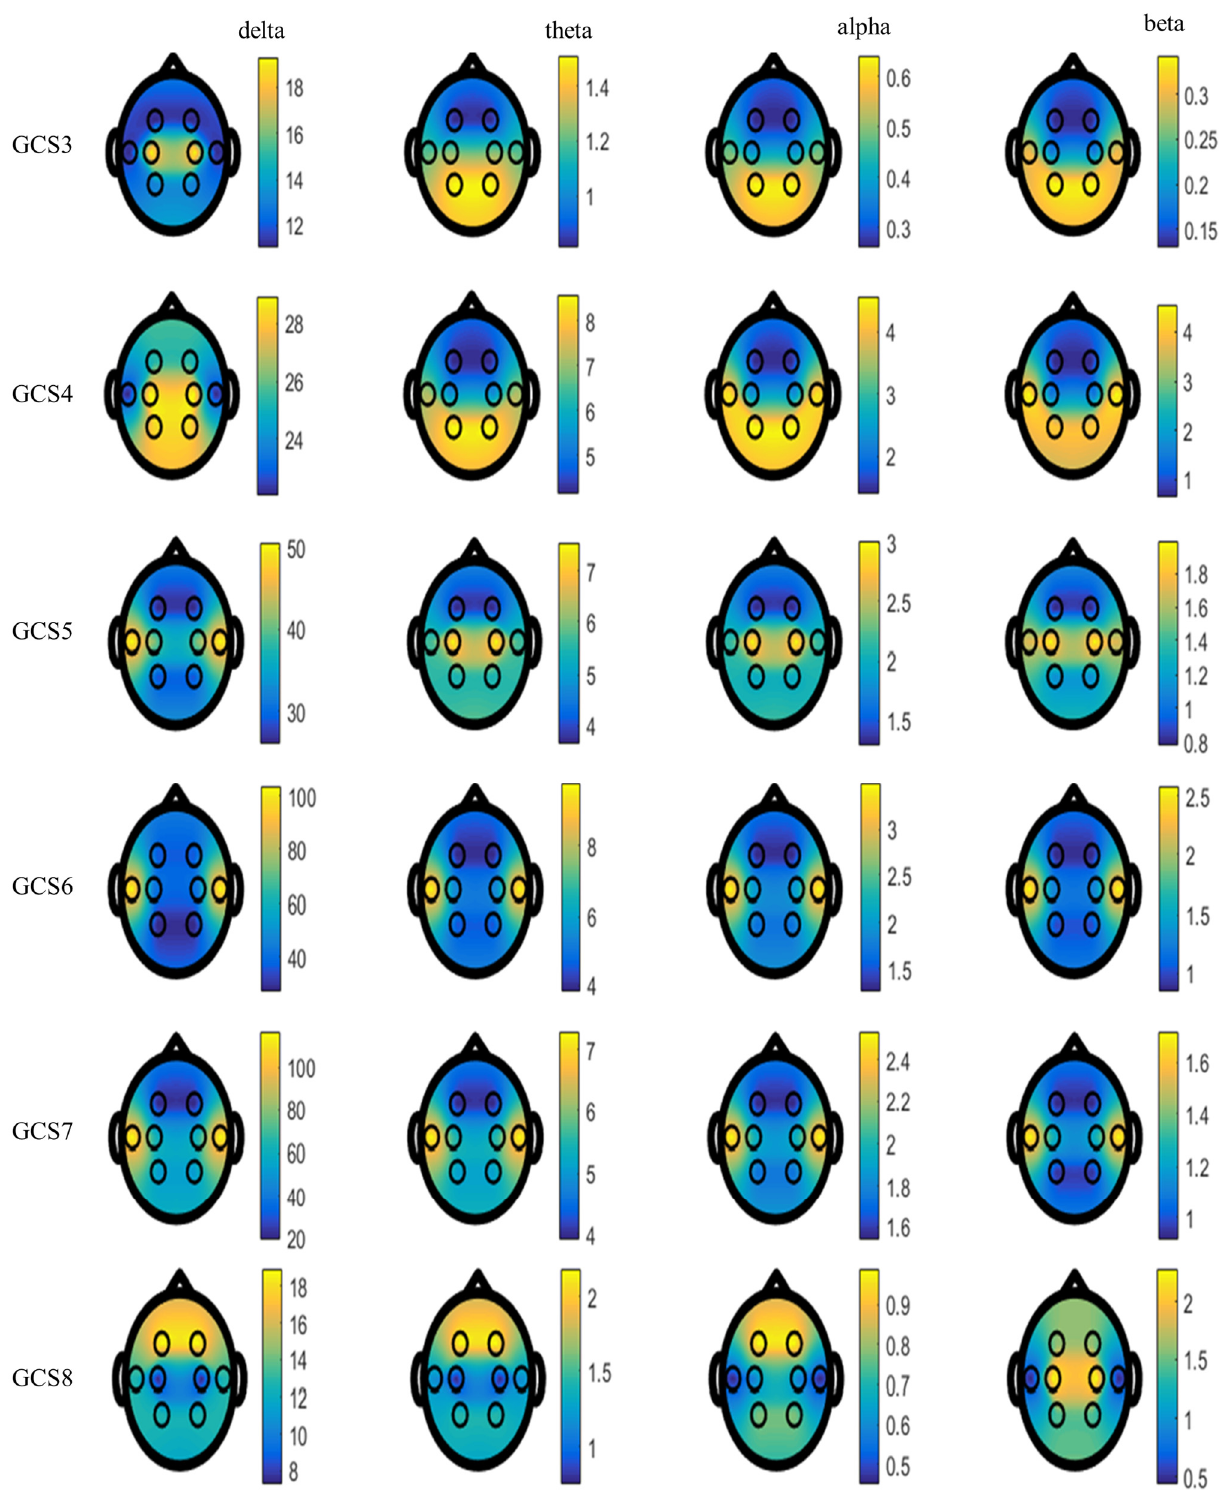
Figure 7. Topographical plots of mean energy values for sub-bands in GCS groups.